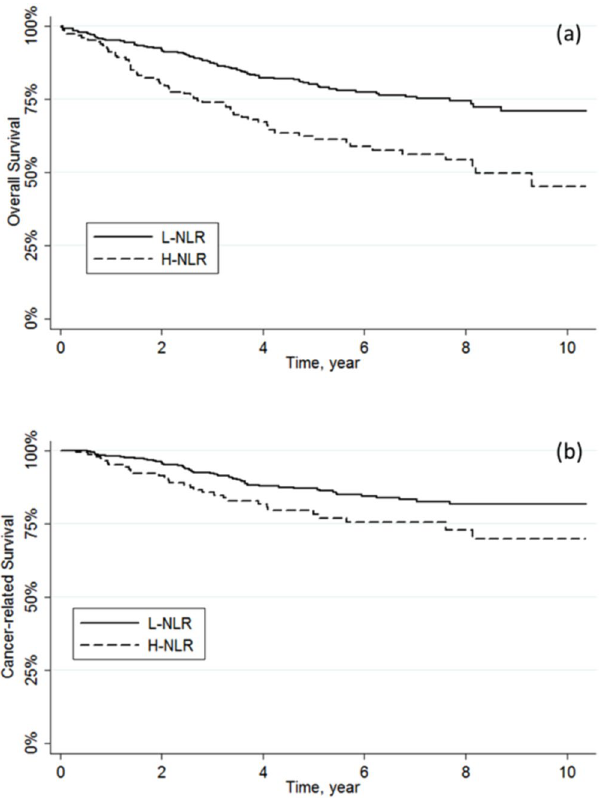
Figure 2. Kaplan-Meier curves for ( a ) overall survival (p < 0.001) and ( b ) cancer-related survival (p = 0.022) stratified by